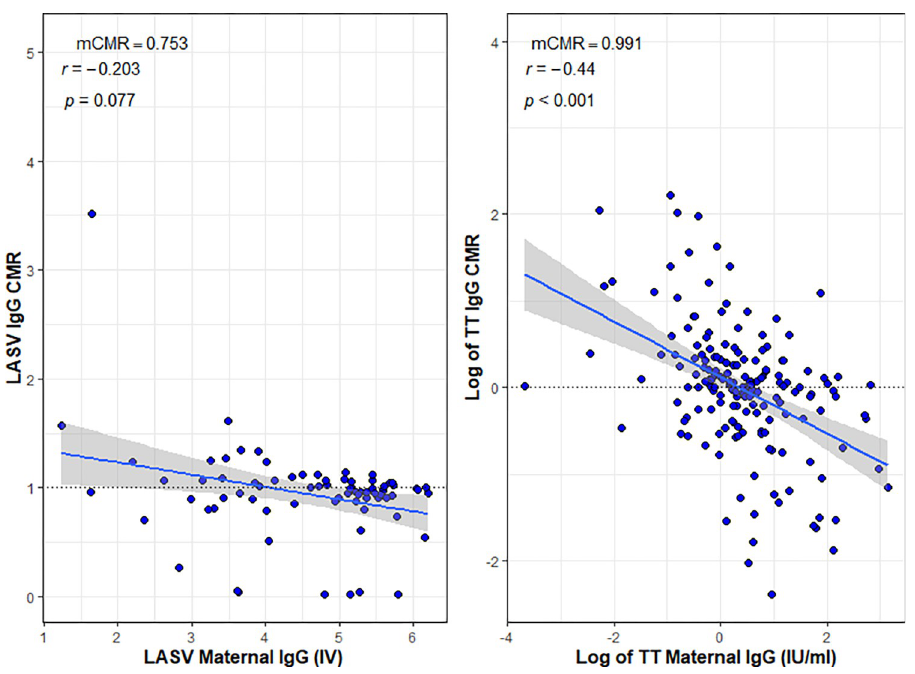
Fig 2. Correlation plots between cord maternal ratio and maternal LASV and TT IgG concentrations assessed by Spearman’s correlation (r). Note: mCMR- median cord maternal ratio; IV- index value, an arbitrary antibody concentration unit based on manufacturer’s guide; the dotted black horizontal line is the line of efficient transfer (CMR = 1); Log- natural logarithm; blue line is the regression line; grey shaded are the 95% confidence interval fitted to the regression